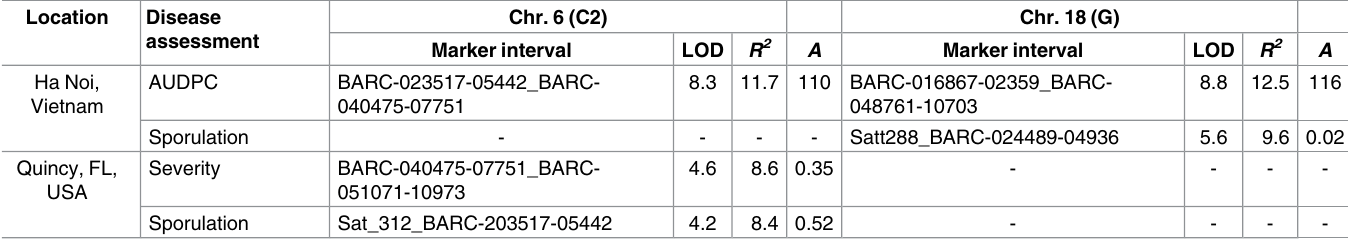
Table 4. Molecular markerintervals, LOD scores, R 2 values, and additive effects (A) of genomic regions associatedwith resistance to soybean rust were calculated from composite interval mapping (CIM) analysis using the program MapQTL 5.0. These regions were mappedon Chrs. 6 and 18 using a F 6:7 mappingpopulationderived from a Williams 82 × DT 2000